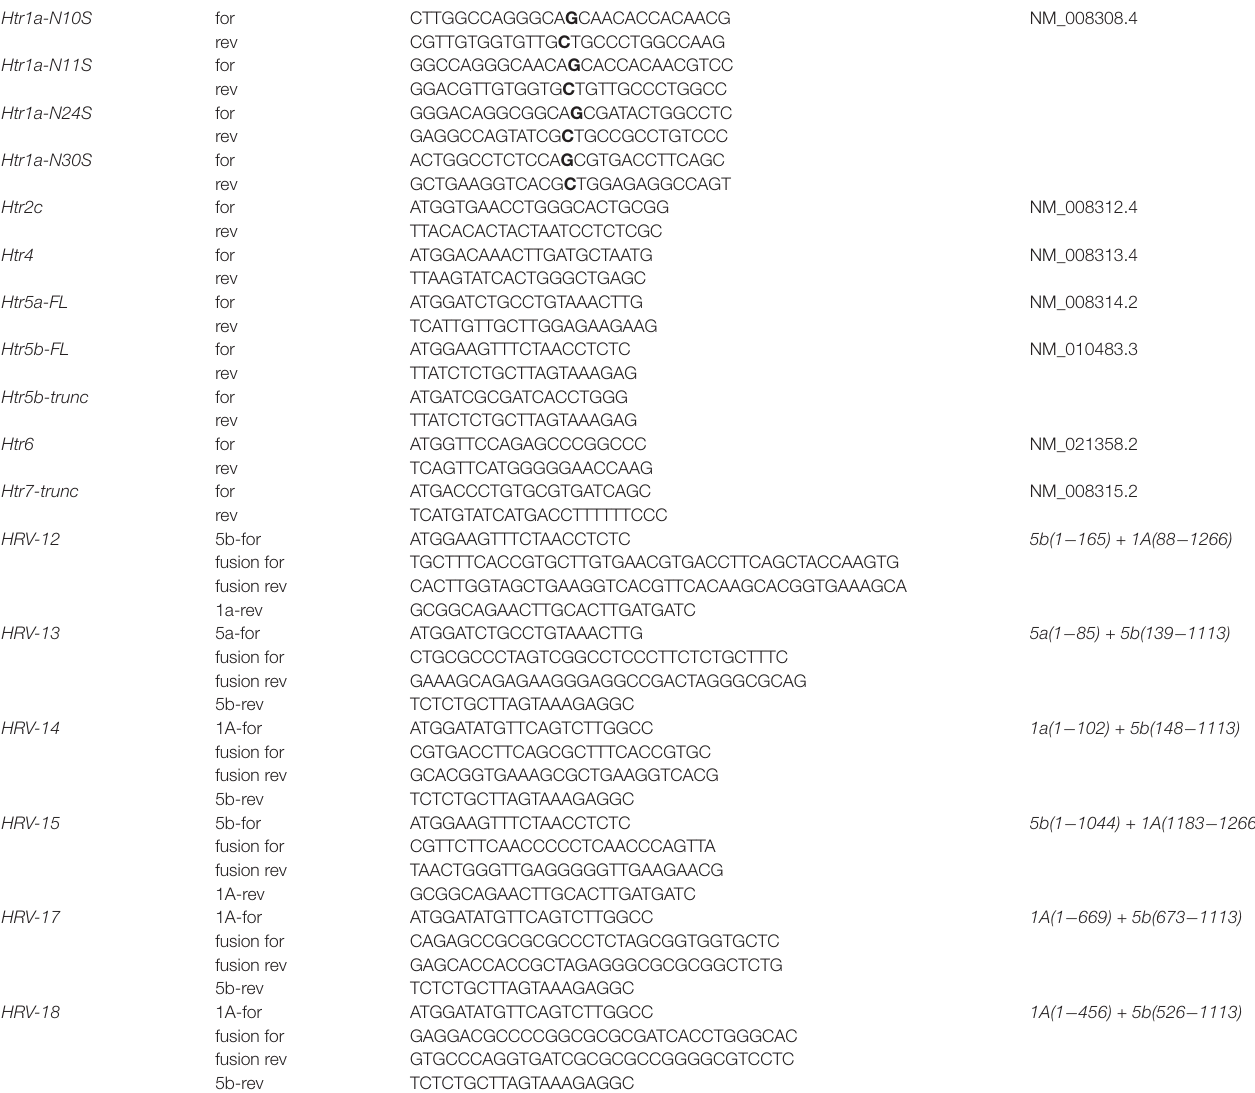
TABLE 1 | List of primers used in this study for